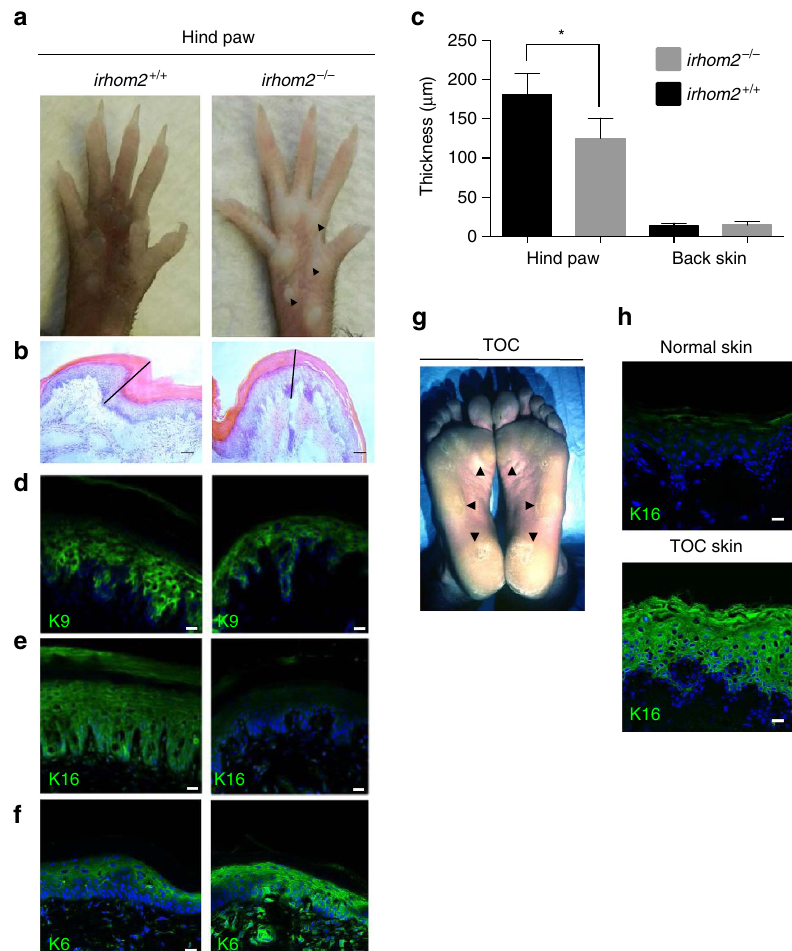
Figure 1 | irhom2 (cid:2) / (cid:2) mice exhibit reduction in epidermal thickness. ( a ) The hind paws of 16-week-old irhom2 (cid:2) / (cid:2) and irhom2 þ / þ littermates ( n ¼ 4 per genotype) were photographed, revealing pallor and diminution of the major stress-bearing paw footpads calluses (black arrowhead) in adult irhom2 (cid:2) / (cid:2) mice. ( b ) Haematoxylin and eosin-stained cross-sections of hind-paw footpads showed a reduction in thickness of the epidermis (black line) in irhom2 (cid:2) / (cid:2) mice. Scale bars, 50 m m. ( c ) Graph depicts the mean thickness of the epidermis of hind paw and back skin from irhom2 þ / þ and irhom2 (cid:2) / (cid:2) mice calculated from ten individual measurements in five separate cross-sections from each genotype ( n ¼ 3); error bars denote s.d., * P o 0.05 (Student’s t -test). ( d ) Immunohistochemistry showing similar K9 expression in paw skin sections. Scale bars, 20 m m. ( e ) Immunohistochemistry demonstrating reduction of K16 expression in paw skin sections. Scale bars, 20 m m. ( f ) Immunohistochemistry showing upregulation of K6 expression in the hind paw epidermis of irhom2 (cid:2) / (cid:2) mice compared with irhom2 þ / þ . ( g ) TOC patient feet showing symmetrically thickened skin at pressure-bearing sites (black arrowheads) on the plantar epidermis. ( h ) TOC skin demonstrates increased K16 expression throughout the epidermis in comparison with control inter- follicular skin. Scale bars, 20 m